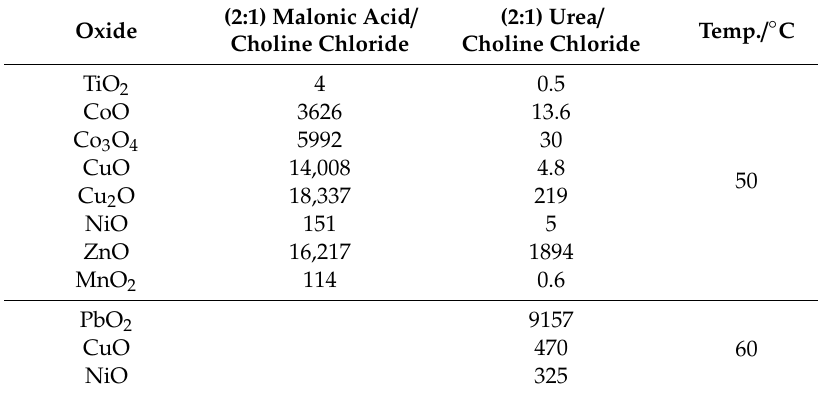
Table 3. Solubility of metal oxides (in ppm) in DES